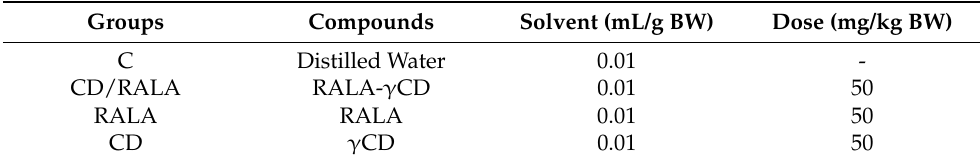
Table 1. Experimental groups and dose of administered substance.